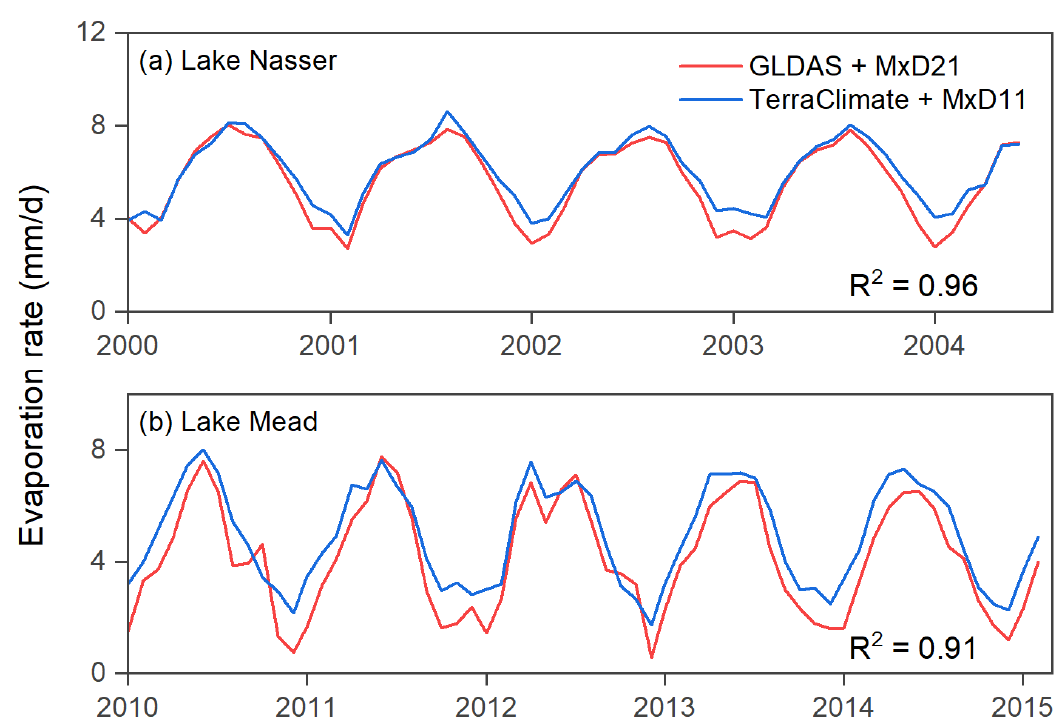
Figure A3. Comparisons of evaporation rates calculated from different datasets (GLDAS + MxD21 and TerraClimate + MxD11) for ( a ) Lake Nasser and ( b ) Lake Mead.